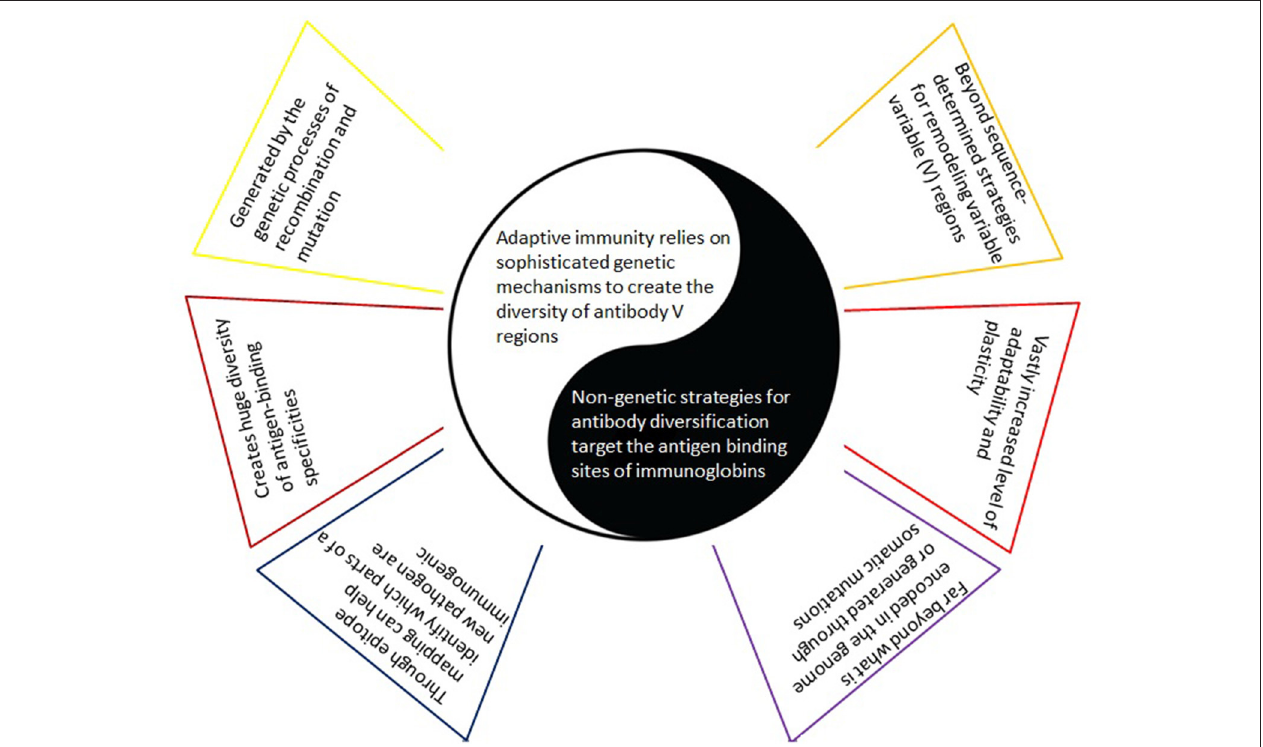
FIGURE 3 | Adaptive immunity based on the usually considered paradigm versus alternative antigen-binding specificities via non-genetic strategies. With the former (left), there is an implicit understanding that a predetermined set of amino acid sequences - representing one or more epitopes on the synthesized vaccine - will trigger the generation of the corresponding antibodies - as a clear and direct response to these amino acid sequences only. In contrast, complementing (yet in many ways opposing) non-genetic mechanisms for improved antigen-binding specificities (right) lead to a much greater level of adaptability and plasticity and include the insertion of non-immunoglobulin proteins, post-translational modifications, the use of non-protein cofactor molecules for antigen recognition, and conformational heterogeneity of the antigen binding